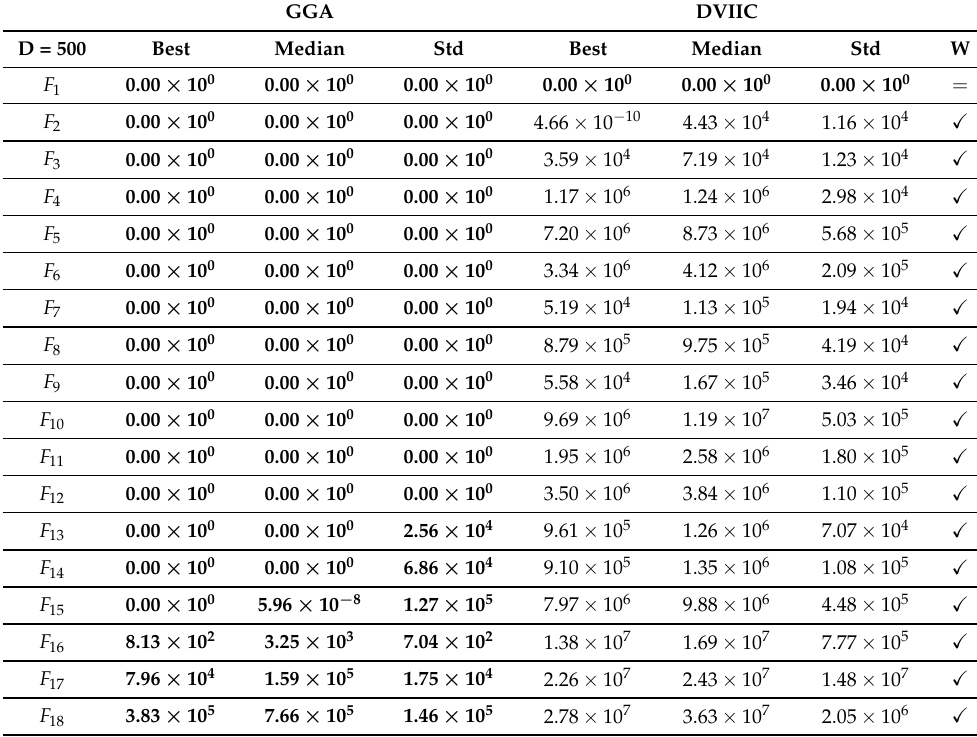
Table 4. Statistical results in dimension 500. Best results shown in